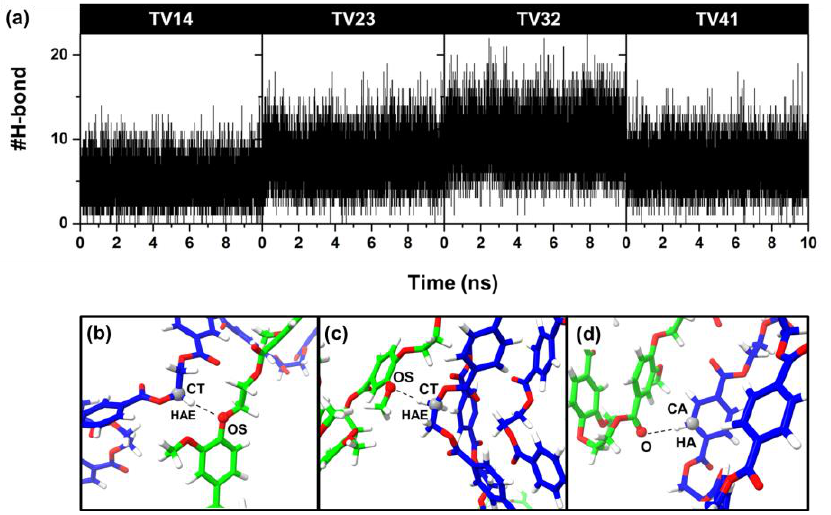
Figure 9. ( a ) The number of hydrogen bonds formed between PET and PEV chains per time. ( b – d ) Examples of hydrogen bonds between PET (blue) and PEV (green) .